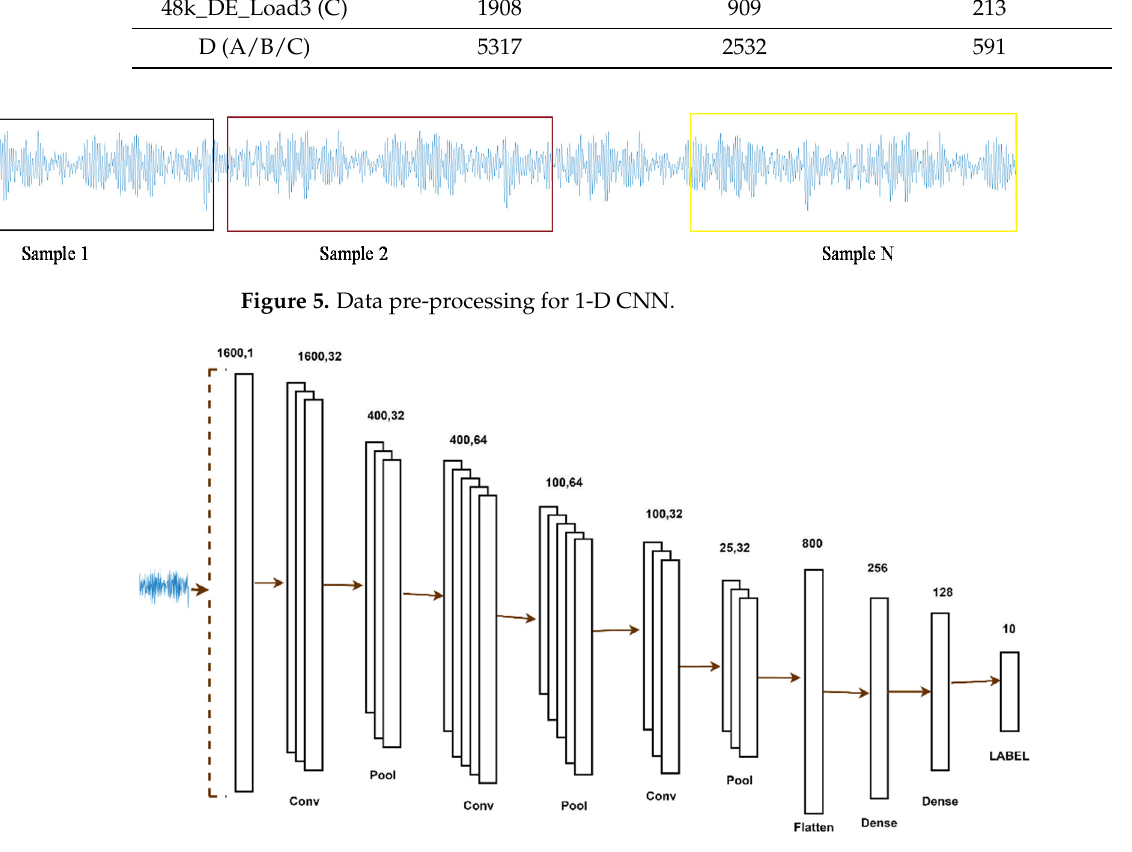
Figure 6. Architecture of proposed 1-D CNN model. Table 3. Network architecture and